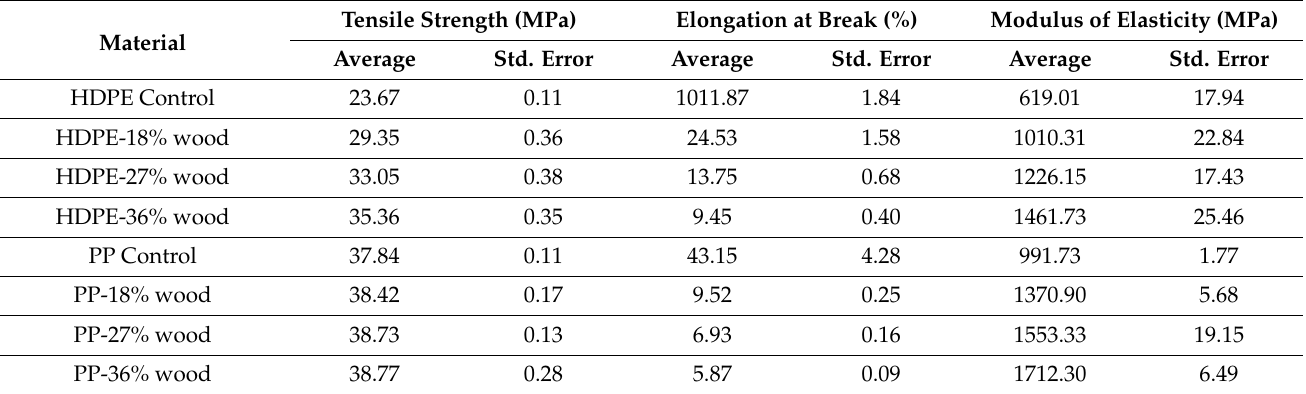
Table 2. Summary of tensile test data for the control samples and three formulations of HDPE and